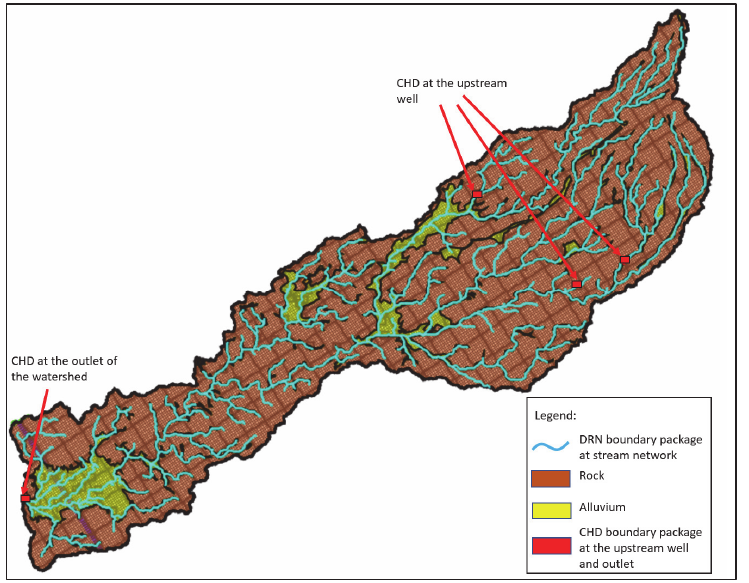
Figure 14. Steady ‐ state groundwater modeling appearances on MODFLOW 6, involve several Figure 14. Steady-state groundwater modeling appearances on MODFLOW 6, involve several boundary conditions packages (i.e., CHD and DRN). boundary conditions packages (i.e., CHD and